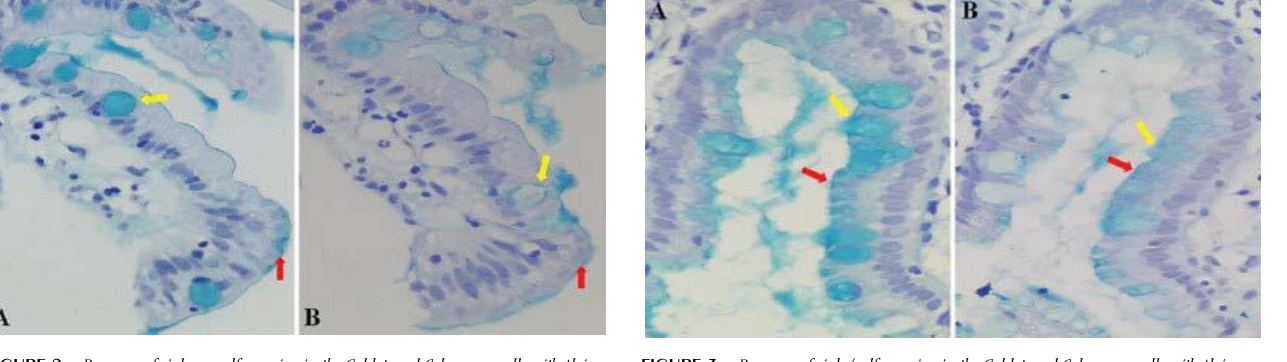
fIGuRE 3 – Presence of sialo/sulfomucins in the Goblet and Columnar cells with Alcian Blue at pH 2.5 (A). Confirmation of sulfomucins in the Goblet and Columnar cells with Alcian Blue at pH 0.5 (B). Interpretation of the algorithm: Intestinal Metaplasia-Type III. Red arrow: Columnar Cell. Yellow arrow: Goblet cell. Objective: